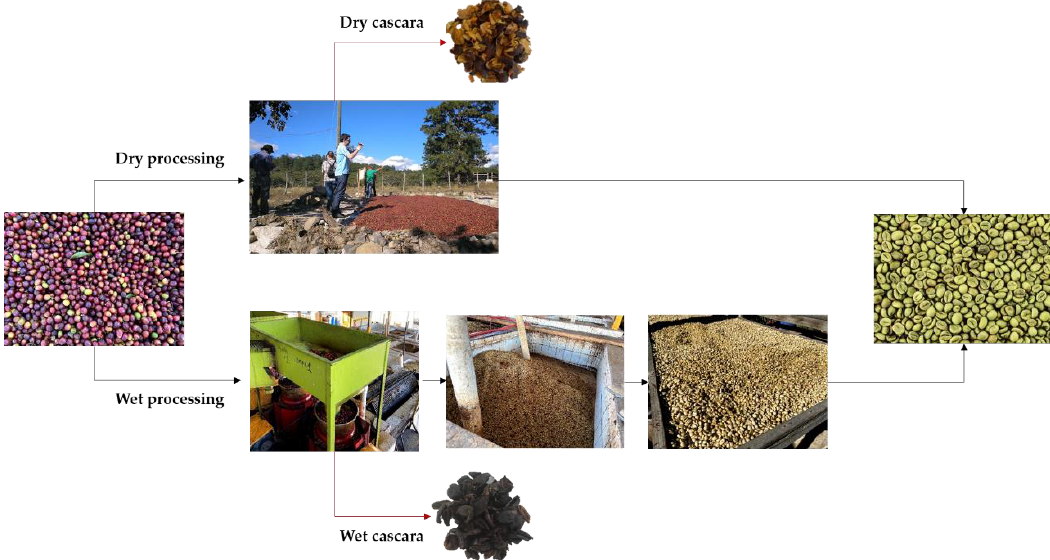
Figure 1. Dry (top) and wet (bottom) processing of coffee cherries. Photographs were taken in Combrifol and Café Orgánico Marcala S.A. (COMSA), Marcala, Honduras.